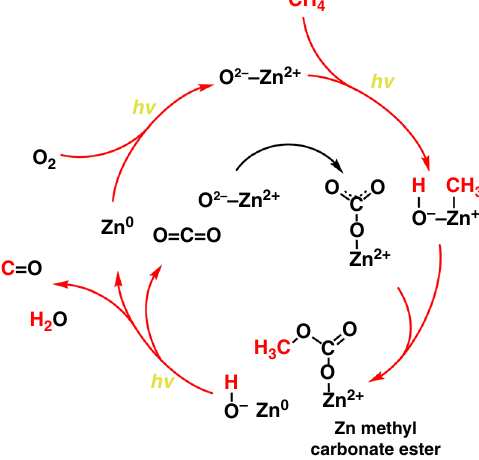
Fig. 6 Reaction steps in methane photo-oxidation over Zn-HPW/TiO around 3020 and 1300 cm − 1 , respectively). At longer reaction time, gaseous carbon monoxide was identi fi ed by rotation- stretching bands at 2150 cm − 1 . In agreement with the results of photocatalytic tests, the intensity of the carbon monoxide FTIR band at 2150 cm − 1 increases with the reaction time.